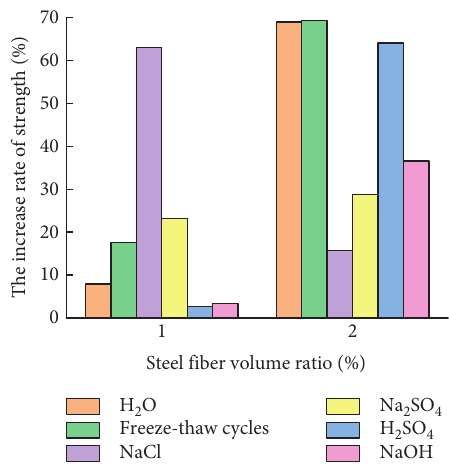
Figure 17: The increase rate of strength (%).